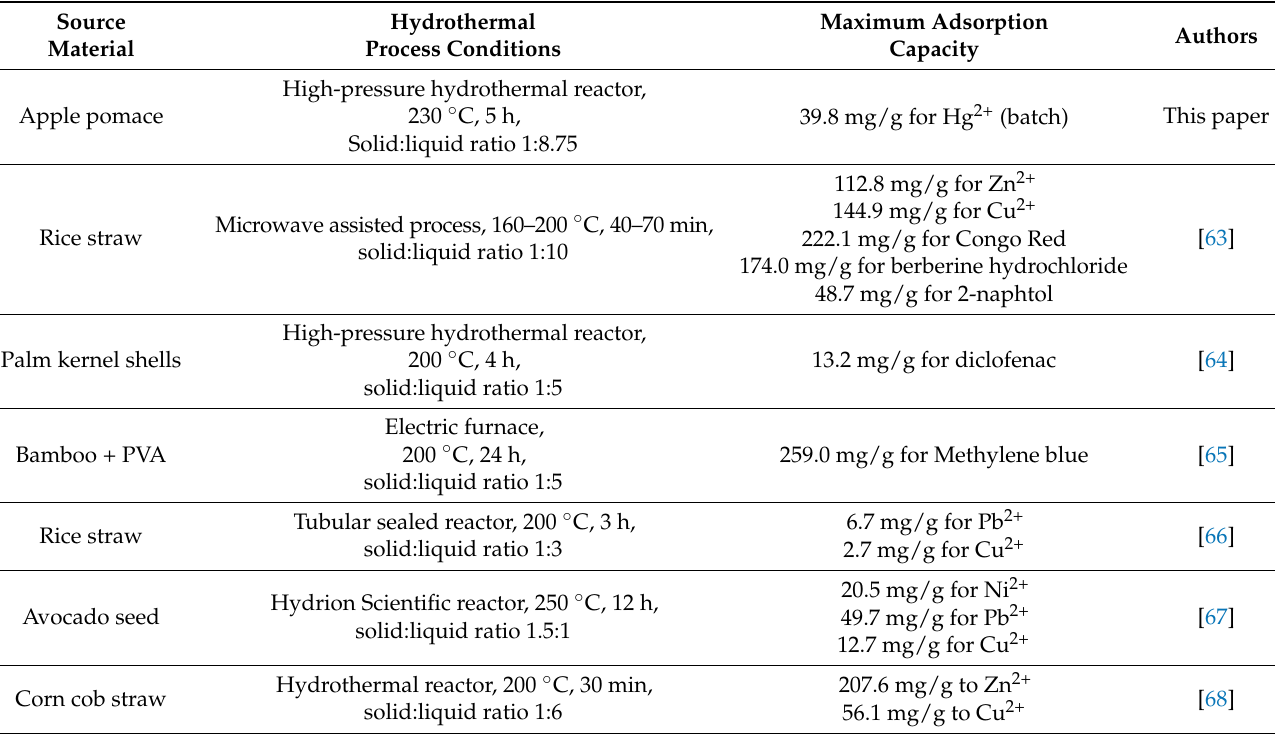
Table 6. Comparison to other hydrochars available in the